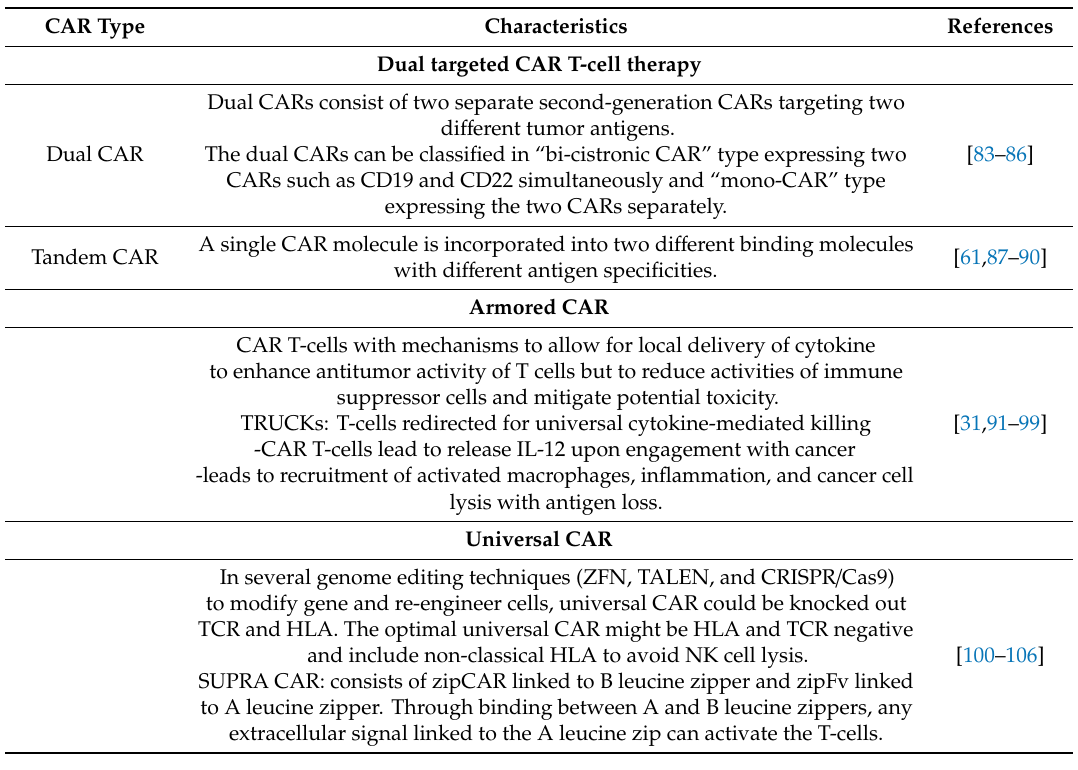
Table 2. Therapeutic strategies to overcome CD19 antigen-negative relapse. CAR